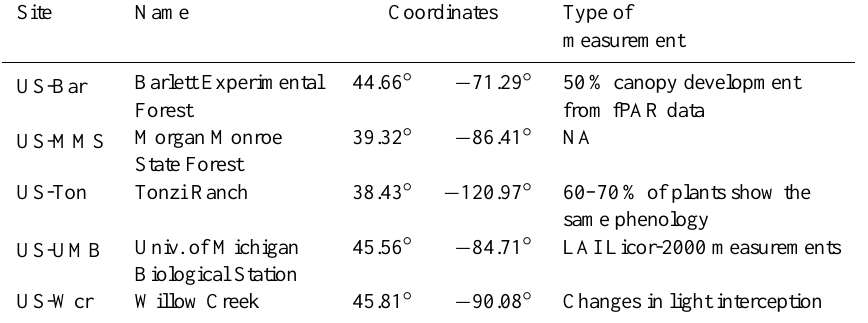
Table 1. Field sites where phenological data was available for model validation.Obtained from the FLUXNET fair-use database.